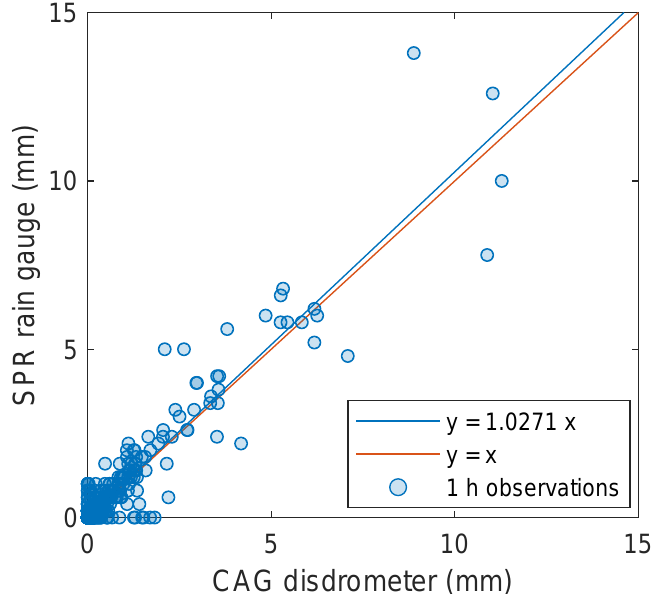
Figure 5. Scatterplot of one hour rainfall depths measured by the CAG disdrometer and the SPR rain